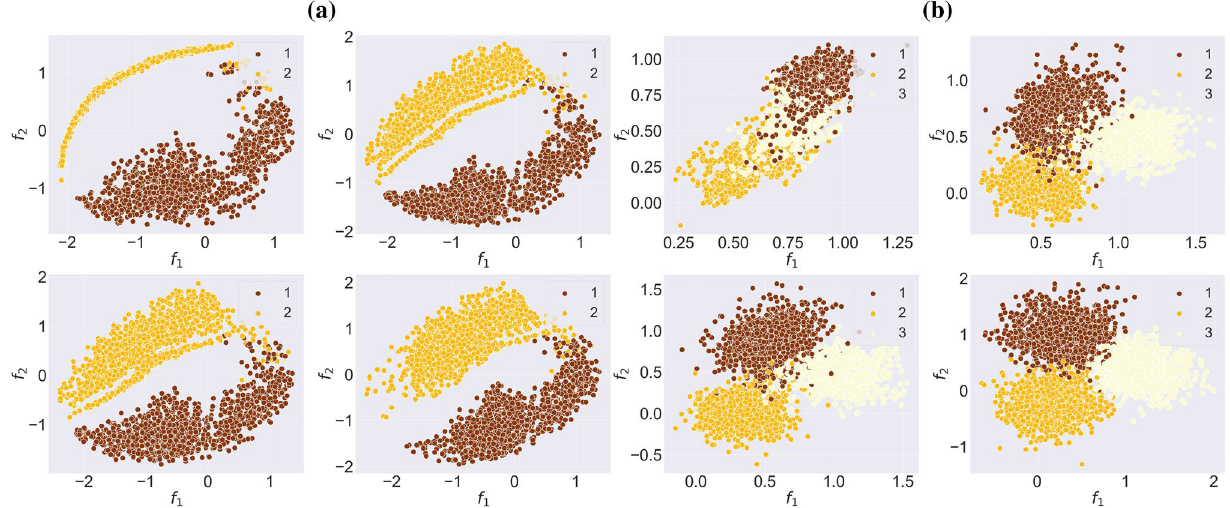
Figure 2. The evolution of the graph embedding of the time-evolving graph G during the training of our model on ( a ) npos_2WellGraph and ( b ) pos_3WellGraph. The points are coloured according to ground-truth